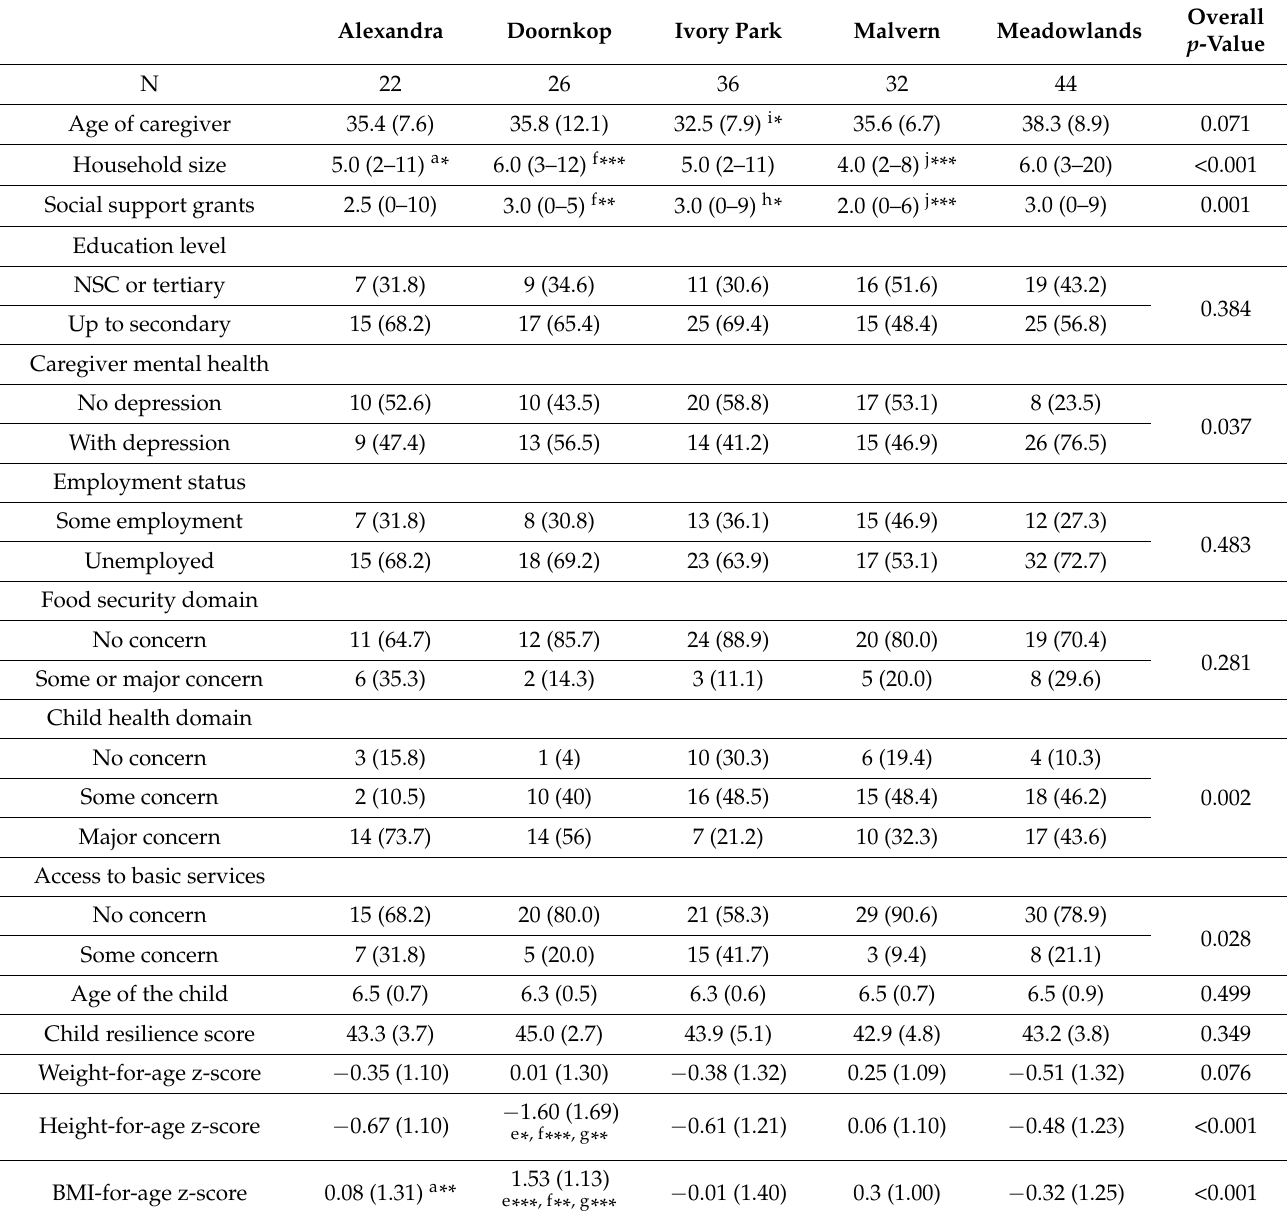
Table 4. The effect of school location on demographic characteristics and child growth